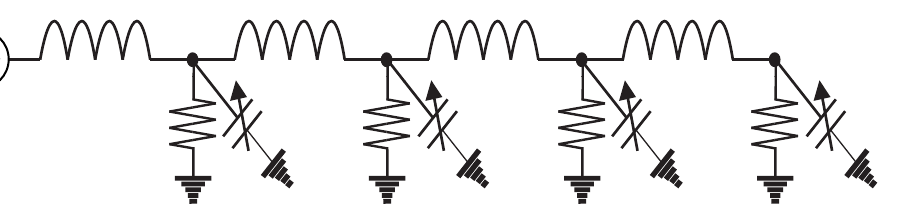
Figure 2. An example of a nonlinear transmission line. A nonlinear transmission line is a nonlinear electrical network on a one-dimensional linear graph.